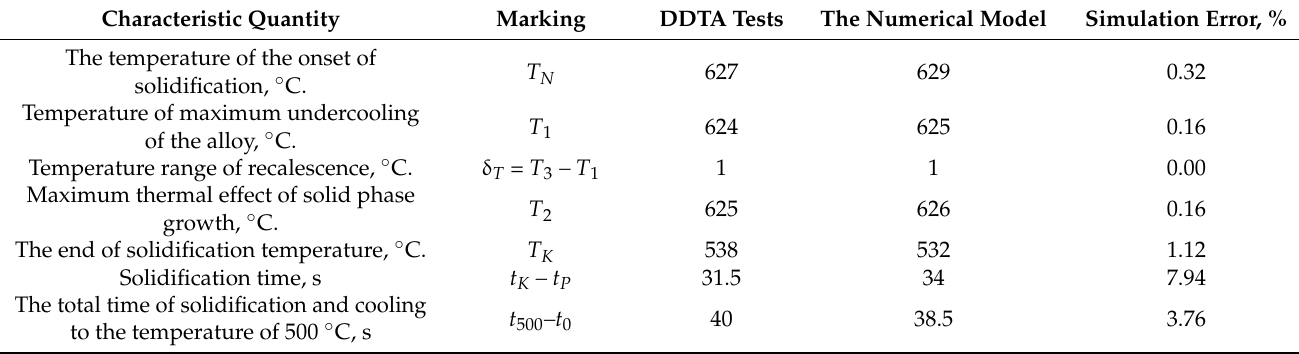
Table 1. Comparison of DDTA test results with results of solidification simulation